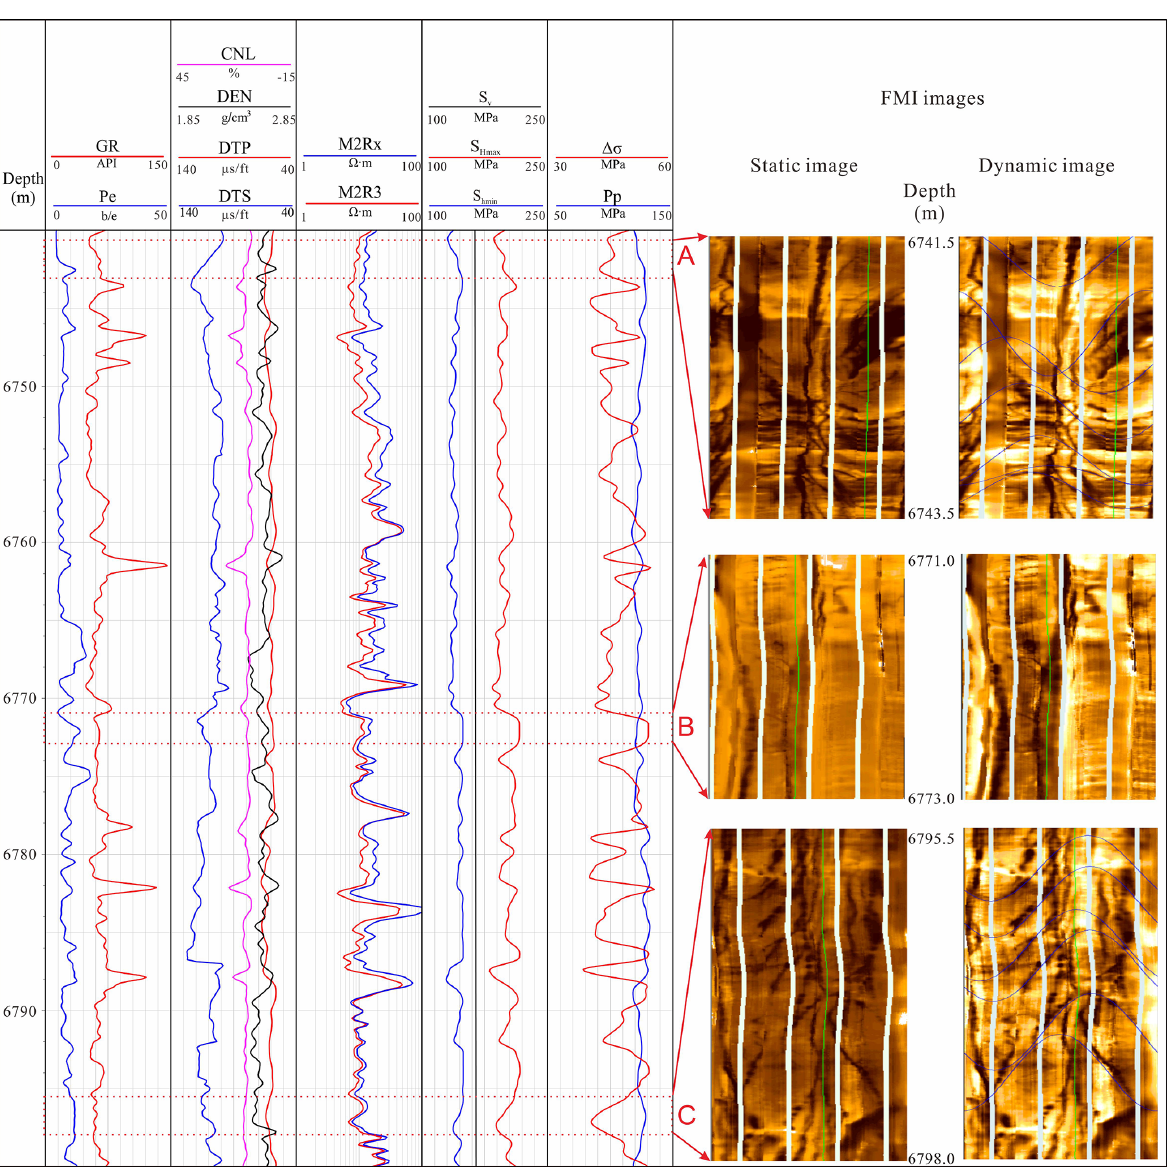
Figure 16. Fracture development within the in situ stress field in Well K8. Note the fractures are related with layers with low horizontal stress